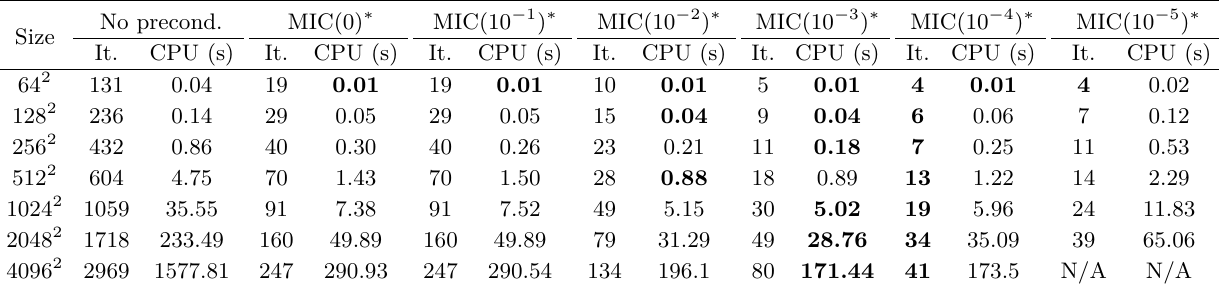
Table 5 Number of iterations and CPU time required to reach a 10 − 4 relative residual for the conjugate gradient algorithm, using the shifted modified incomplete Cholesky (MIC) preconditioner ( α ∗ = 10 − 3 ) with different drop tolerances and different “Phantom” sizes. The 10 − 3 drop tolerance is the one which provides the fastest results. Using a larger drop tolerance allows a reduced number of required iterations, but the time used for computing the preconditioner dramatically increases. Note that we were unable to compute the preconditioner MIC(10 − 5 ) ∗ for the 4096 2 dataset, because 32GB of memory was insufficient